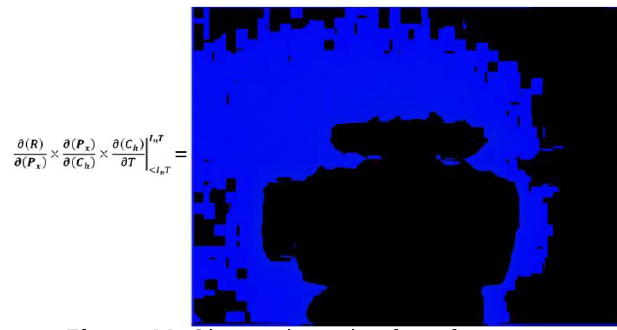
Figure 11. Chromatics value for reference temperature level with canonical formation